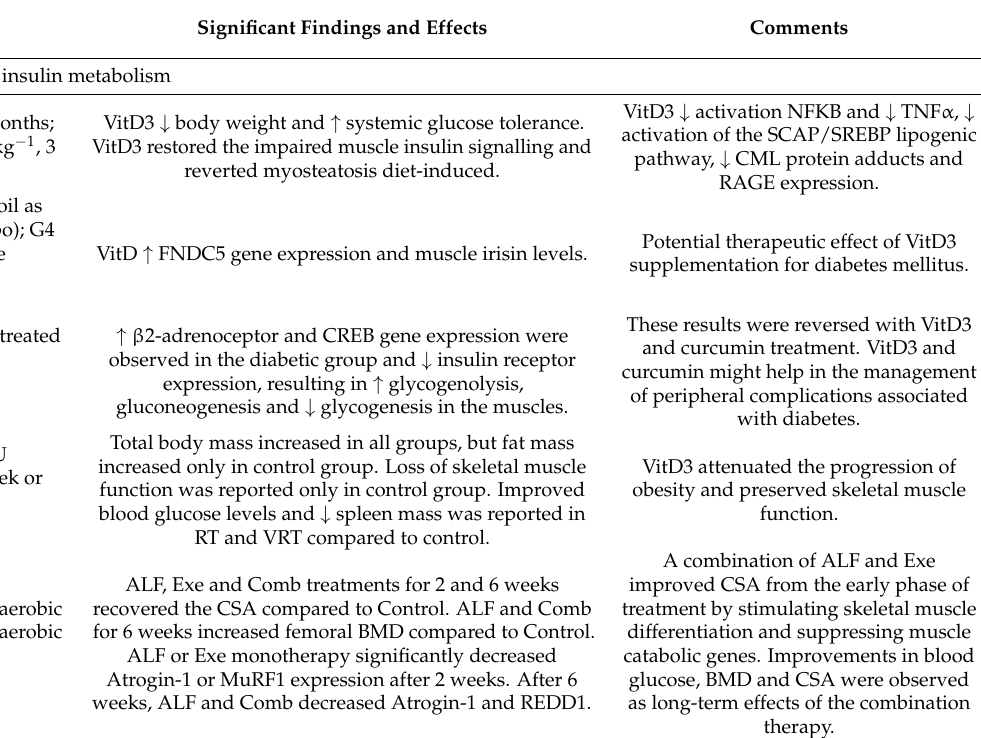
pathway, ↓ CML protein adducts and RAGE